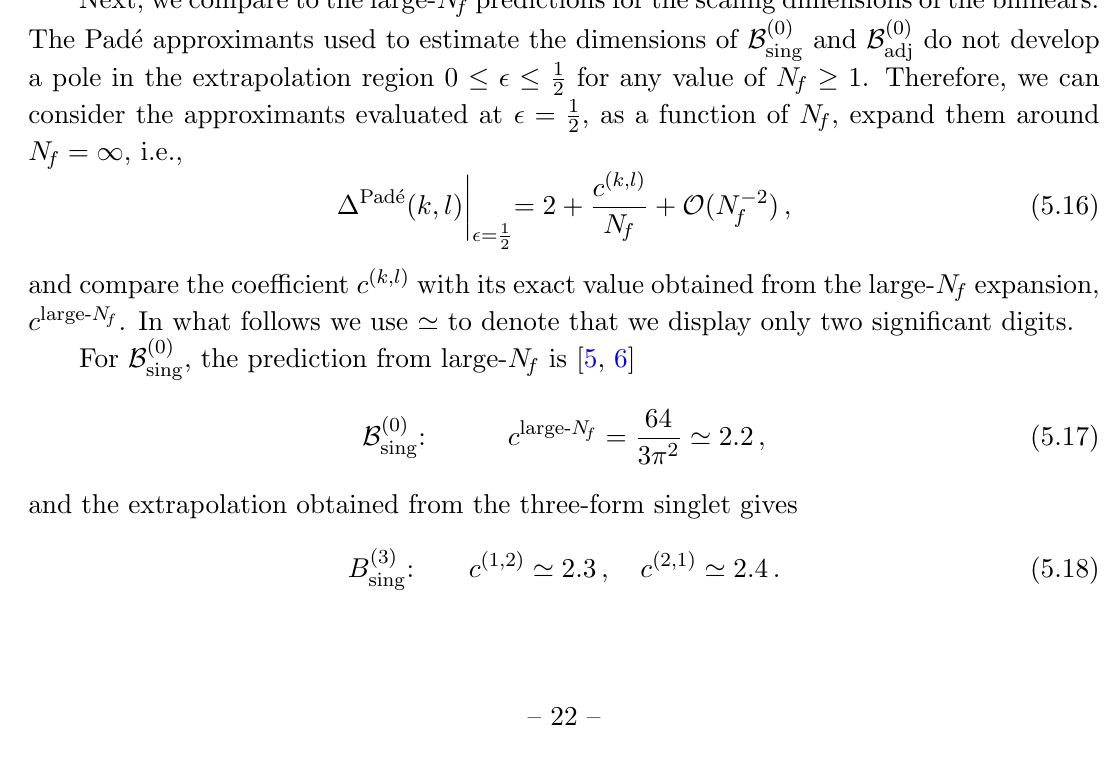
Figure 4 . (cid:15) -expansion predictions for the scaling dimension of the bilinear vector operator B (1) at d = 3. The operator is associated to the conserved (cid:13)avor-nonsinglet current of SU(2 N f ), thus its scaling dimension is expected to equal 2. We observe that the N 2 LO Pad(cid:19)e approximations are indeed close to this expectation even for small values of N f